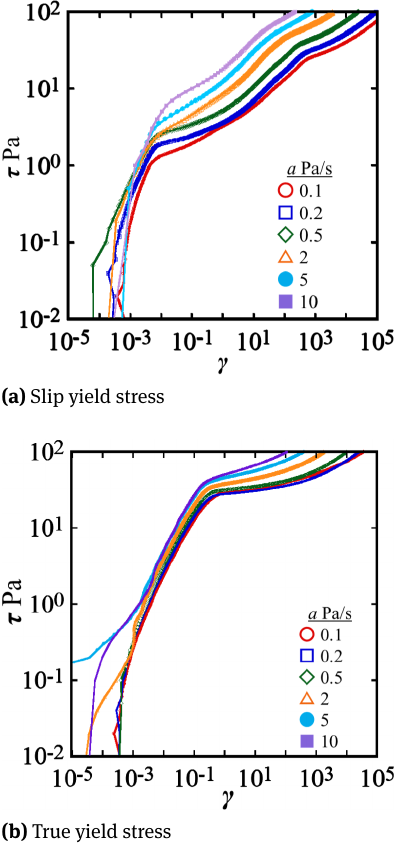
Figure 12: Influence of stress-ramp rate on (a) slip yield stress/strain and (b) true yield stress/strain